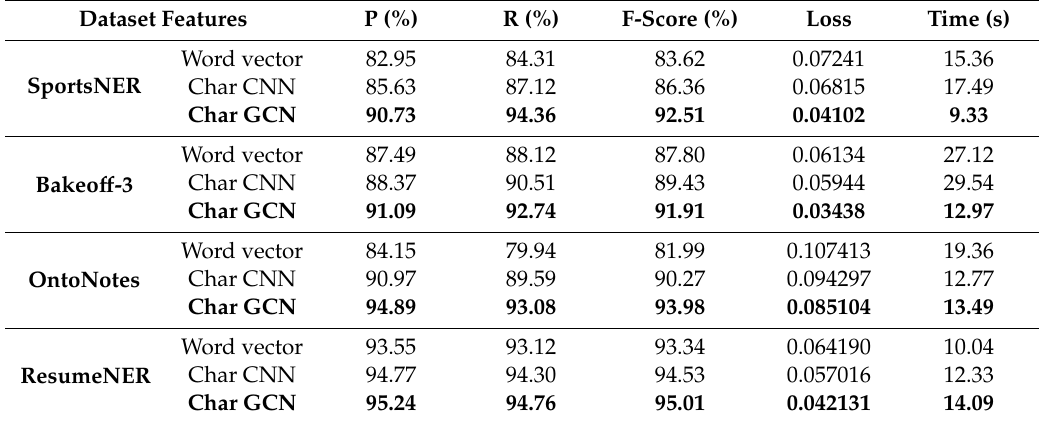
Table 5. Experimental